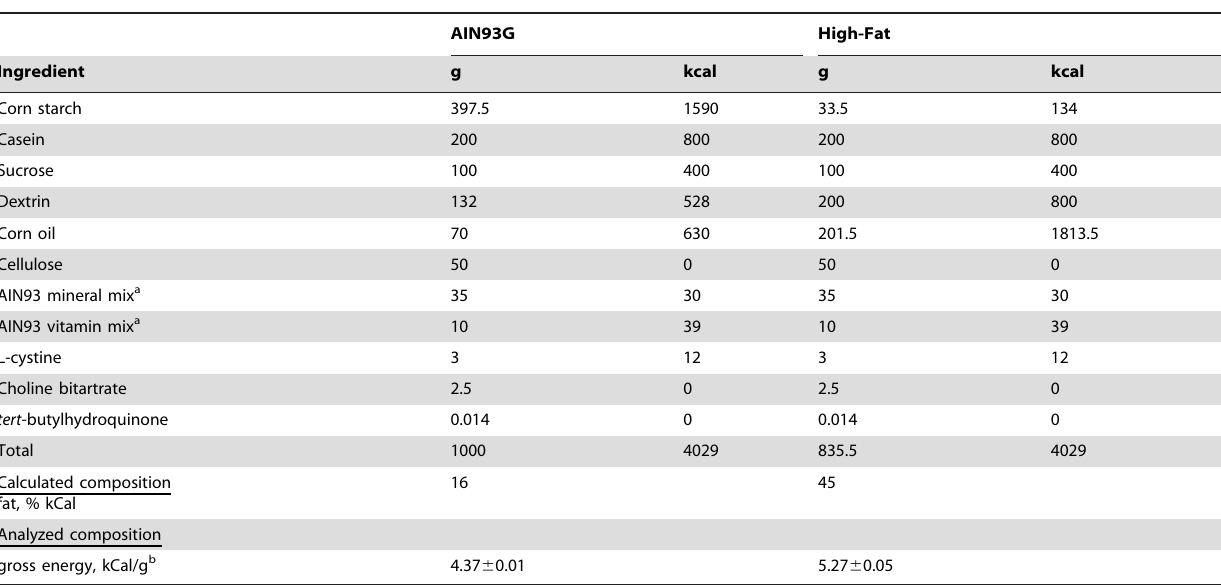
Table 1. Composition of experimental